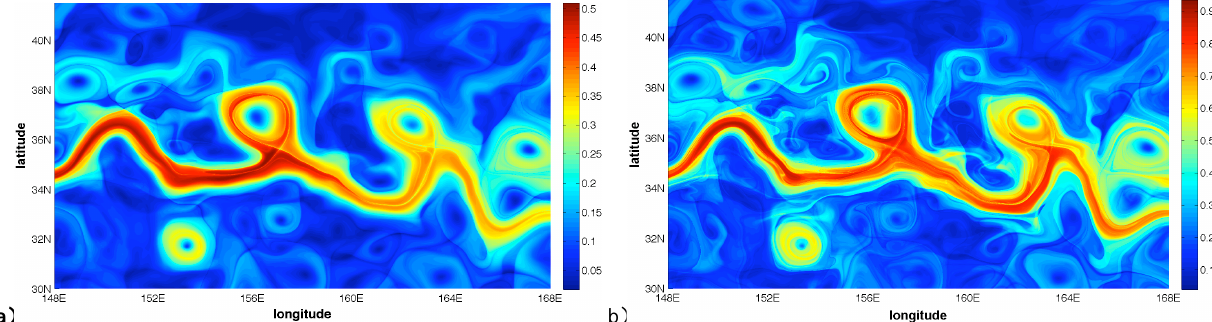
Fig. 7. Evaluation of the function M over the Kuroshio current between longitudes 148 ◦ E–168 ◦ E and latitudes 30 ◦ N–41 . 5 ◦ N on 2 May, 2003; (a) τ = 15 days; (b) τ = 30 days. (Figure taken from Mendoza and Mancho, 2010).